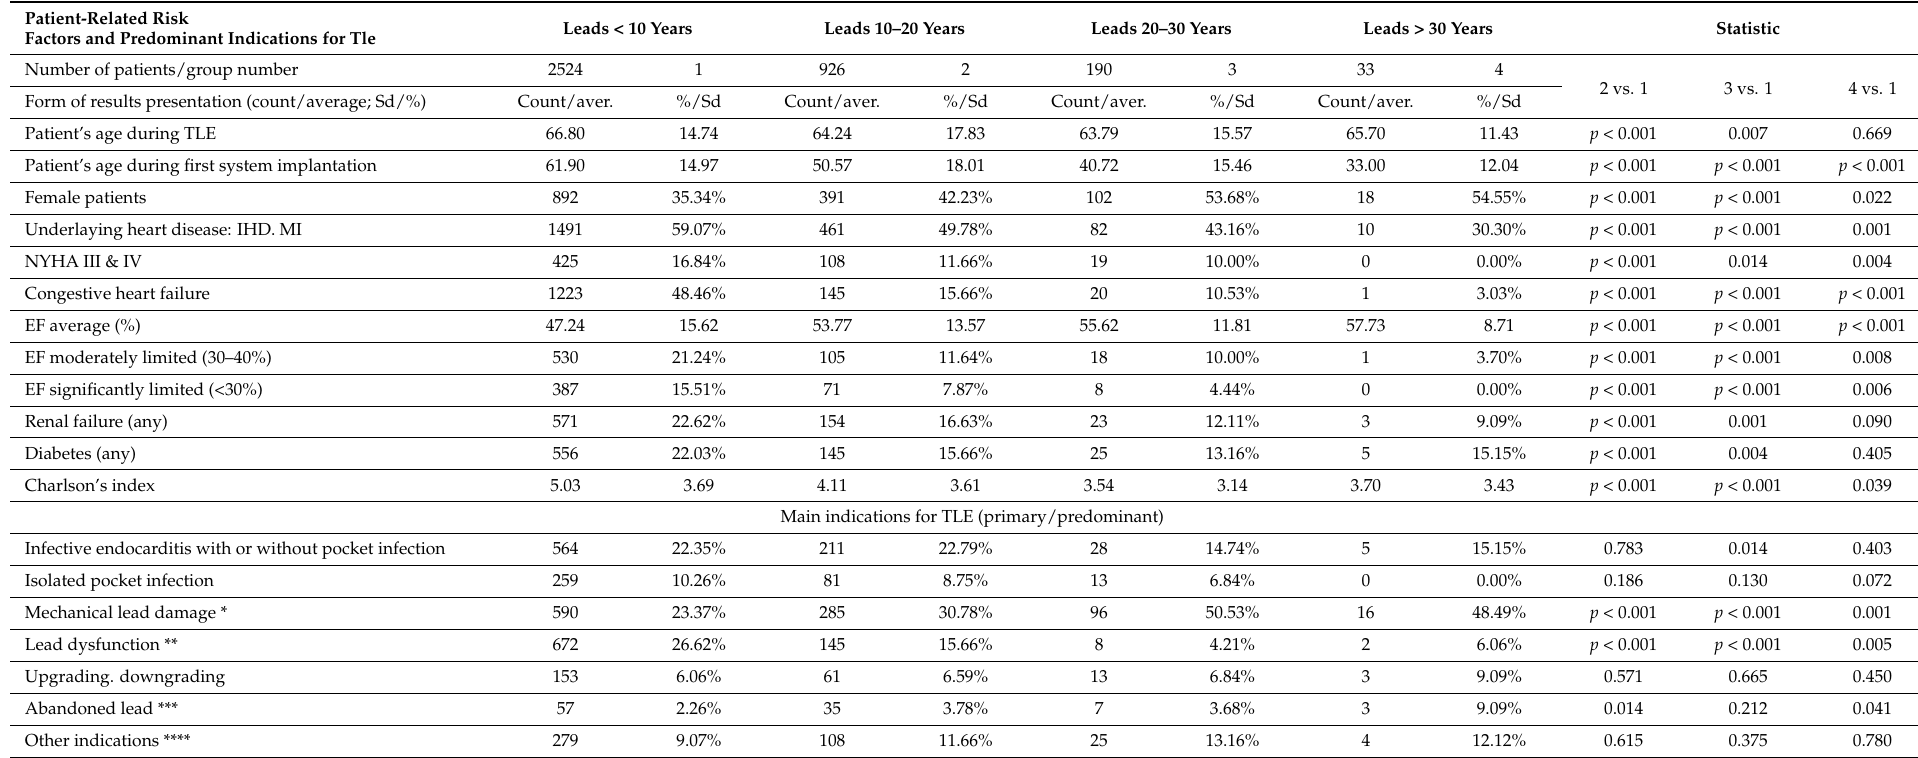
Table 2. Patient-related risk factors of TLE complexity, major complications of TLE procedure and predominant indications for TLE (in 3673